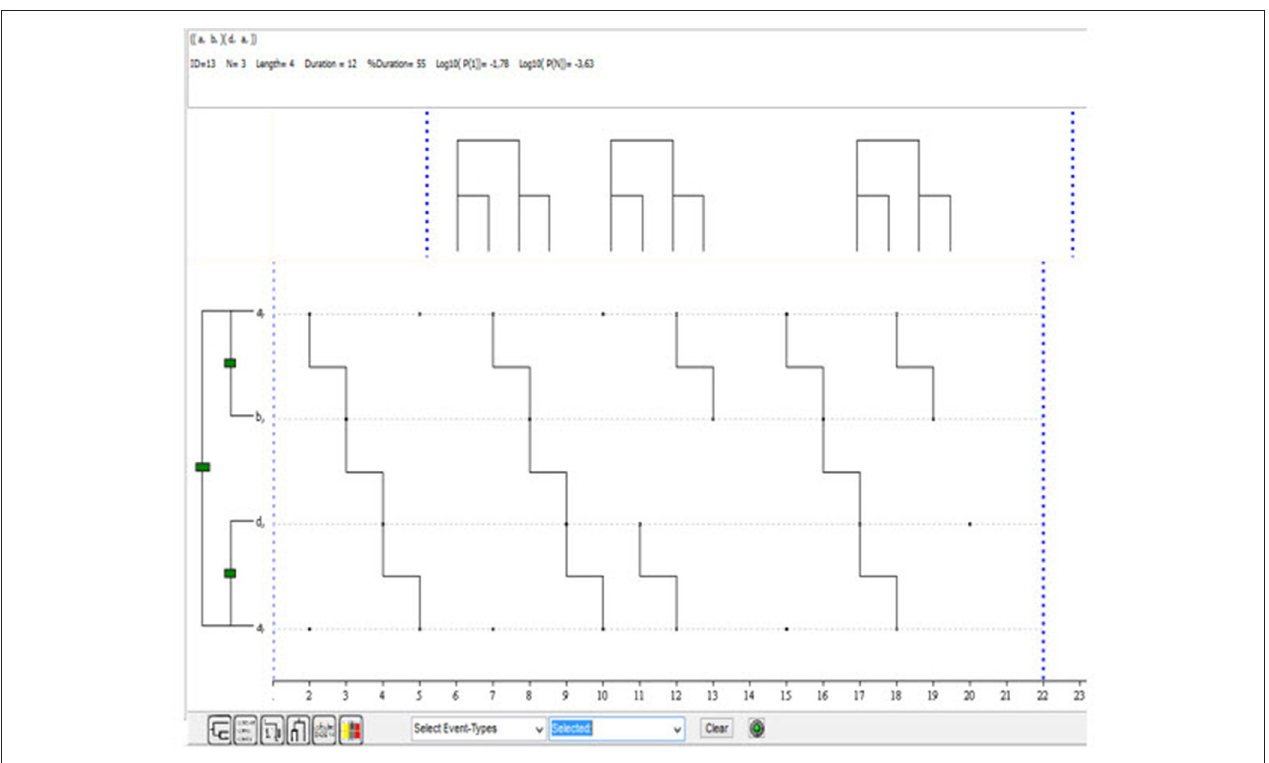
FIGURE 5 | First of the 13 T-patterns detected in the data from Table 3a ( p <